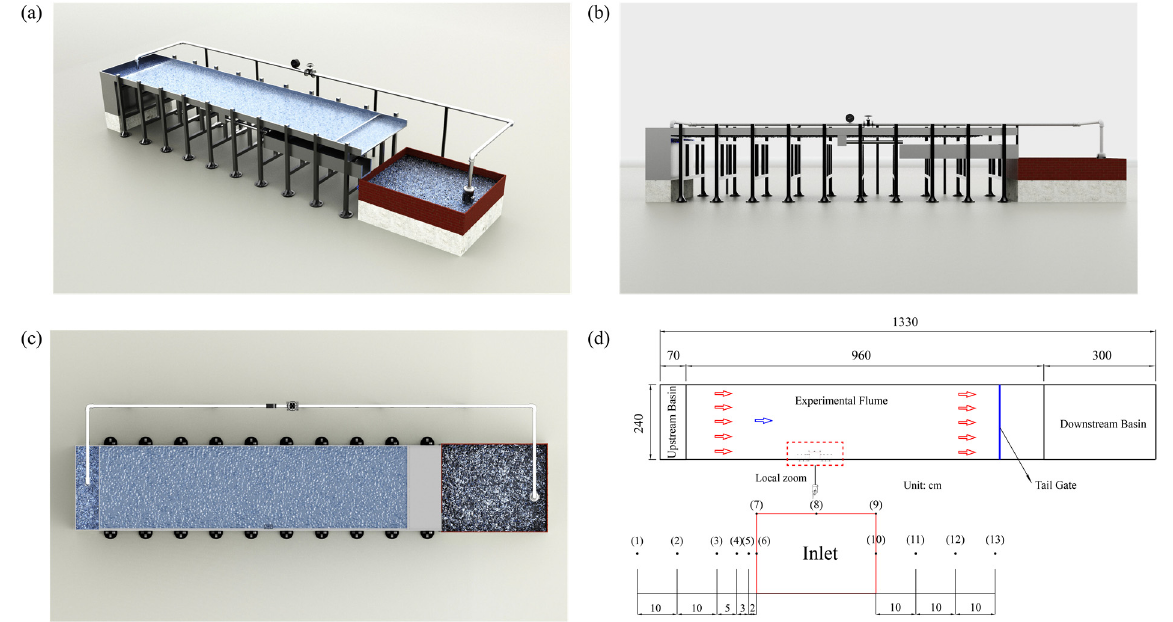
Figure 1. Experimental flume setup. ( a ) Overall view of the flume; ( b ) Side view of the flume; ( c ) Plan view of the flume; ( d ) Size of the experimental flume.